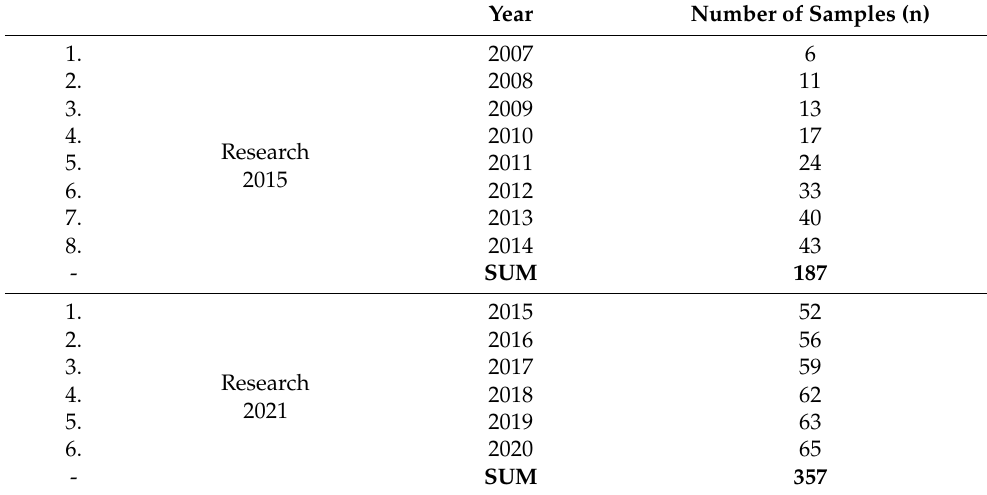
Table 2. Total number of measurements (in calendar